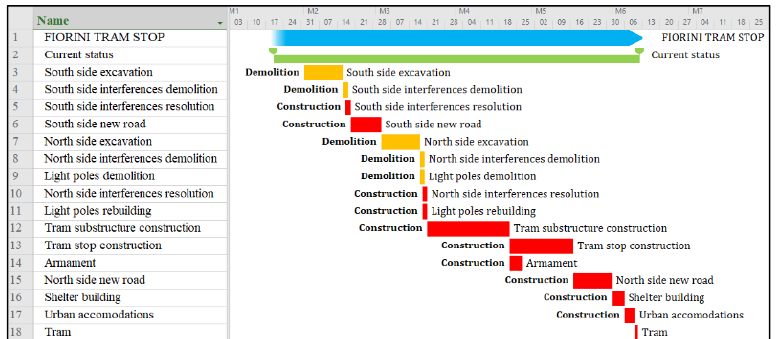
Figure 16. Gantt Chart of construction site phases.